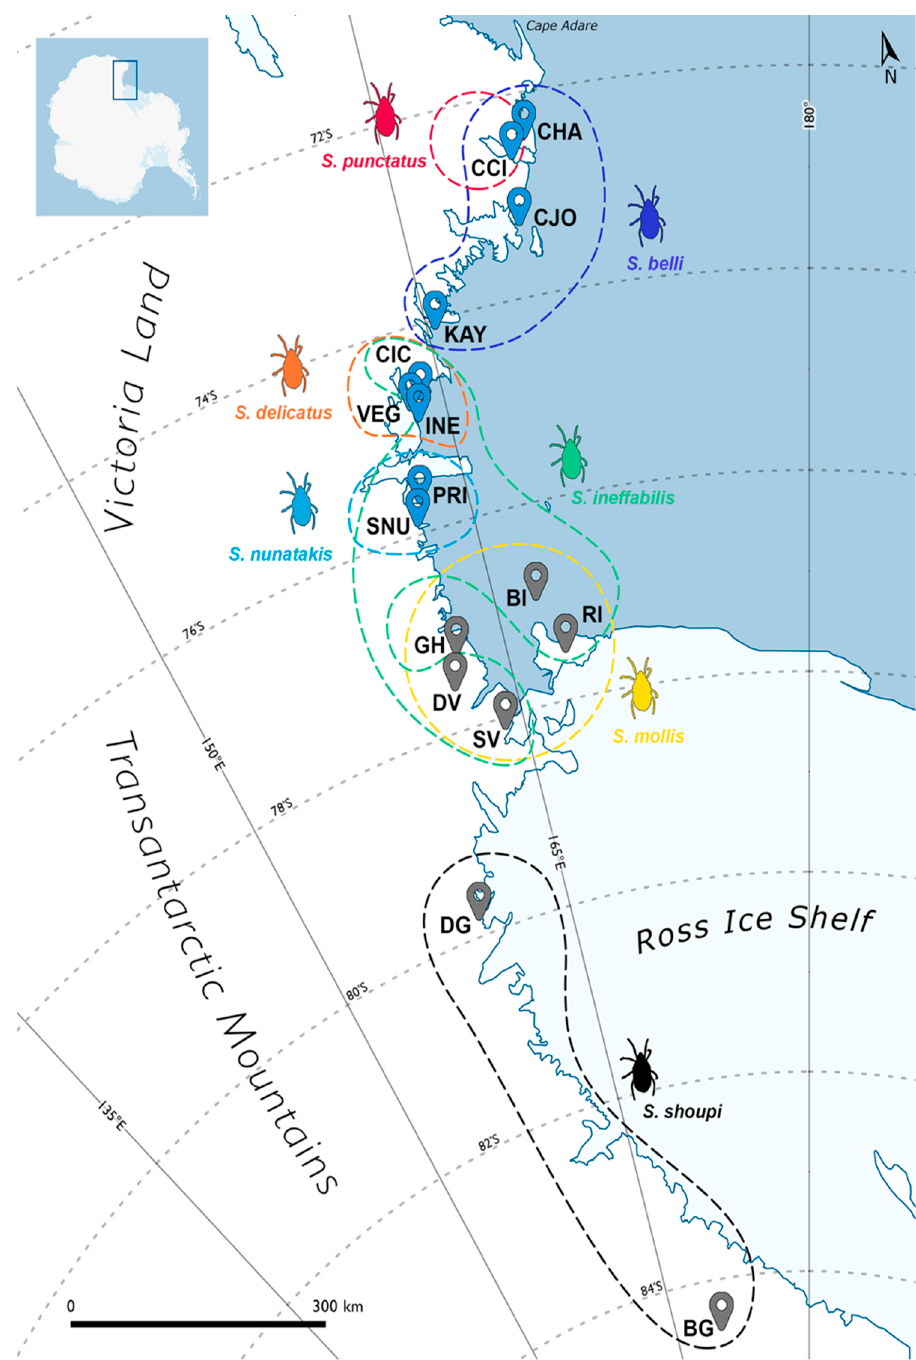
Figure 7. Updated map of the distribution of the Stereotydeus spp. of Victoria Land, based on Figure 7. Updatedmapofthedistributionofthe Stereotydeus spp. ofVictoriaLand, basedonthecombination the combination of new morphological and molecular data obtained this study and [48] (blue) of new morphological and molecular data obtained this study and [48] (blue) and previous molecular data and previous molecular data from [33,34,36] (grey). (coastlines from ADD Simple Basemap, from [33,34,36] (grey). (coastlines from ADD Simple Basemap, NPI/Quantarctica 3 NPI/Quantarctica 3 [60]).